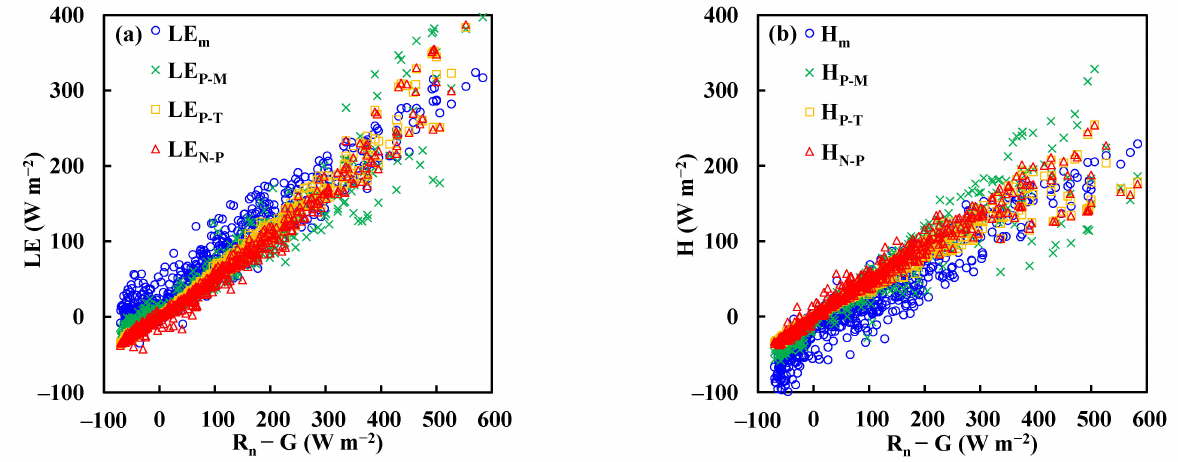
Figure 5. Scatter plots of measured and model-predicted LE ( a ) and H ( b ) as a function of available energy (R n − G) above the grassland.